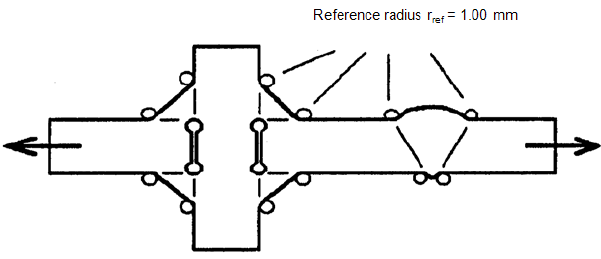
Figure 9: Principle of applying reference radii.